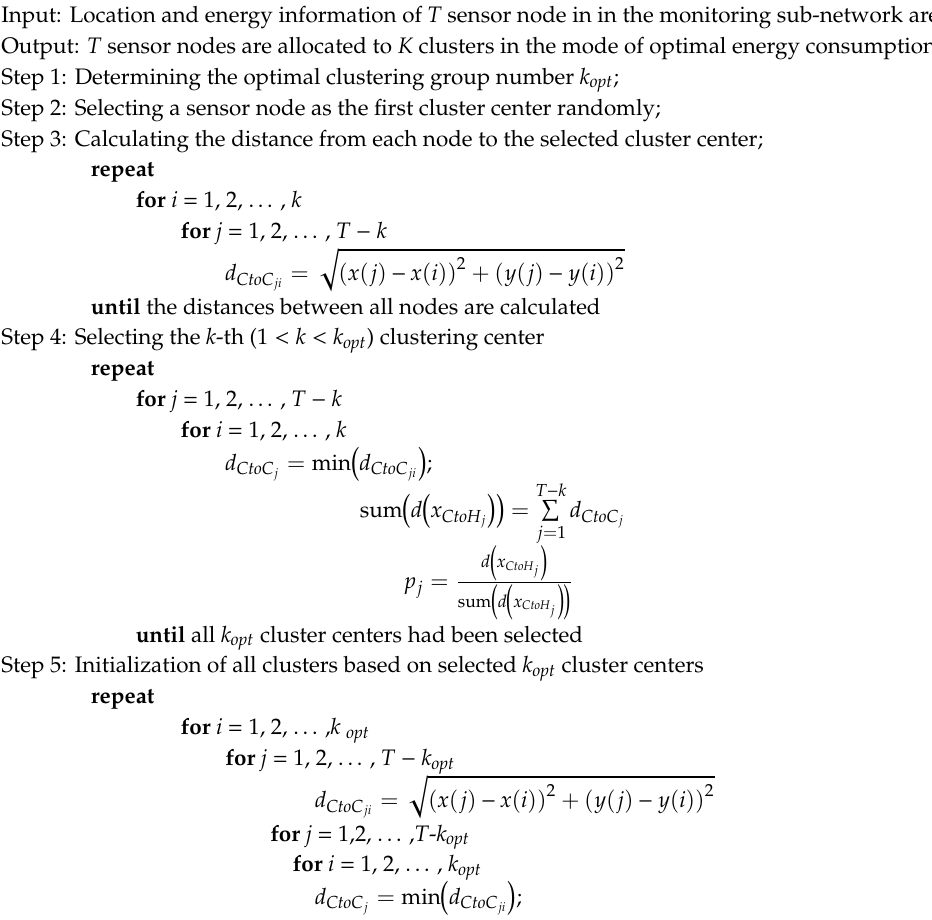
Algorithm 1 Cluster initialization based on improved K-medoids